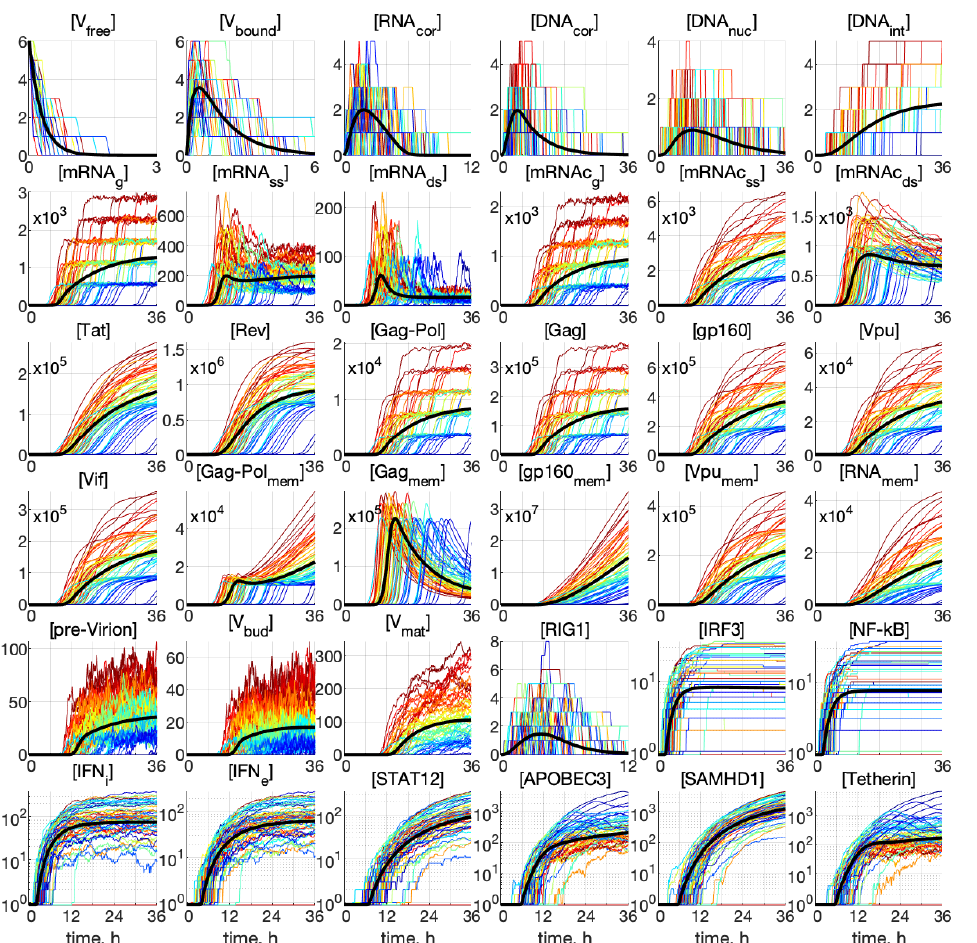
Figure 4. Examples of stochastic realisations for all 36 components for MOI = 6 and [ IFN e ]( 0 ) = 0. The black curves indicate deterministic trajectories. The larger the released progeny, the closer is the colour to the red end of the spectrum, and vice versa, the lower the output, the closer is the colour towards the blue end of the spectrum. The stochastic trajectories deviate essentially from the deterministic curves, indicating that random fluctuations in the reaction rates and low numbers of the reaction species result in essentially heterogeneity in the viral replication components.